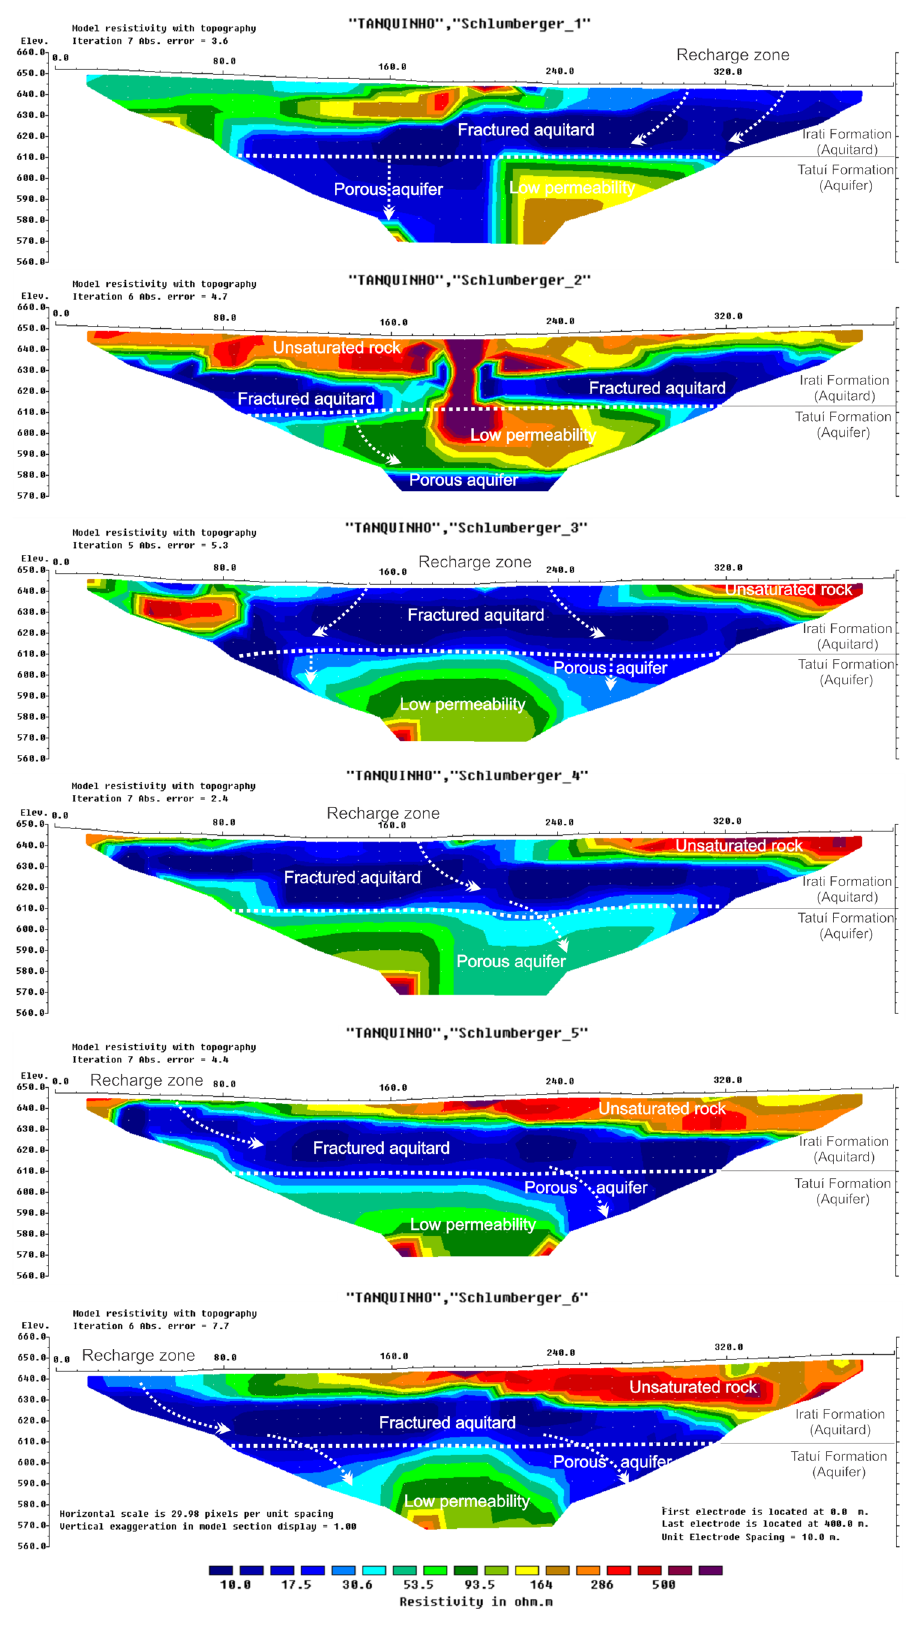
Fig. 7 Inversion models of lines 1 to 6, with emphasis on recharge zones, groundwater flow and contact between geological/aquifers